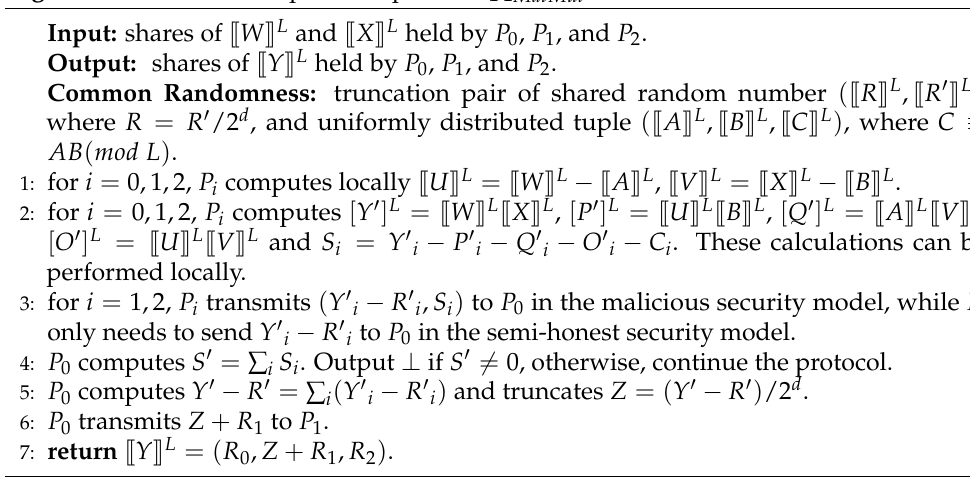
Algorithm 2 Matrix Multiplication protocol ∏